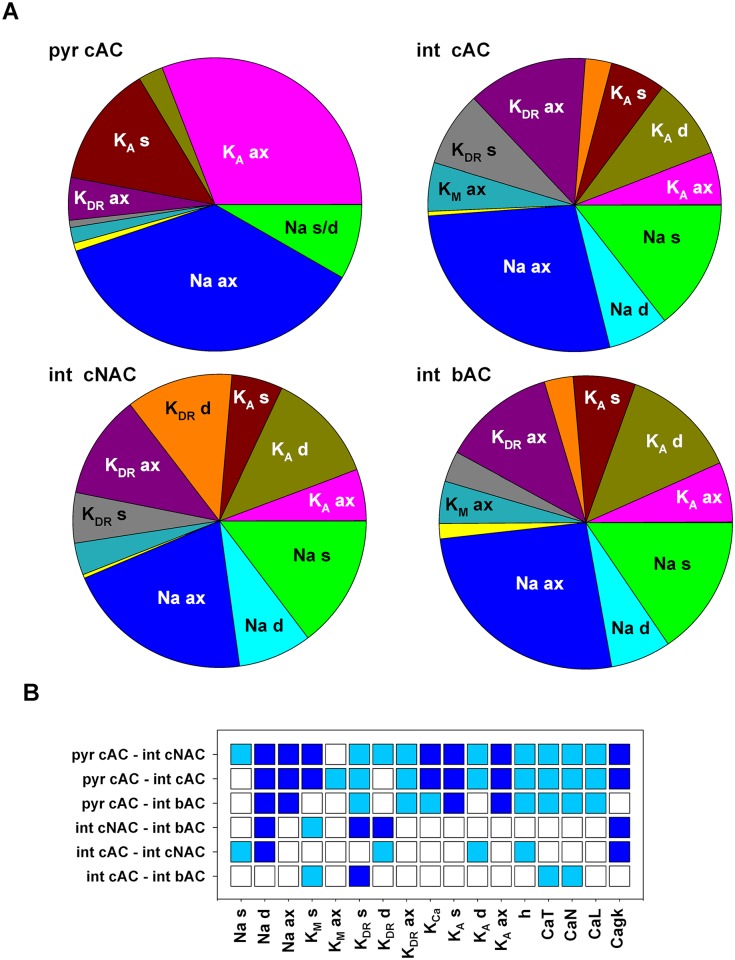
Differences among CA1 neuron populations.(A) Pie charts showing for the different e-types the proportion of each conductance with respect to the total average peak conductance calculated across all individuals. (B) Schematic representation of a Pairwise Multiple Comparison Procedure (Dunn’s Method), between each pair of e-types. The colored boxes indicate cases for which p<0.050. Dark blue or cyan indicates that the average value of the first component is significantly lower or higher, respectively, than the second one. An empty box indicates no statistically significant difference.